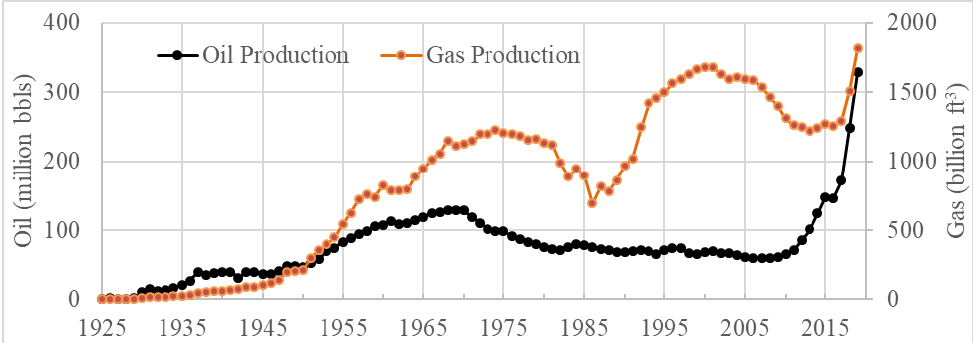
Figure 1. Annual oil and gas production in New Mexico between 1925 and 2019